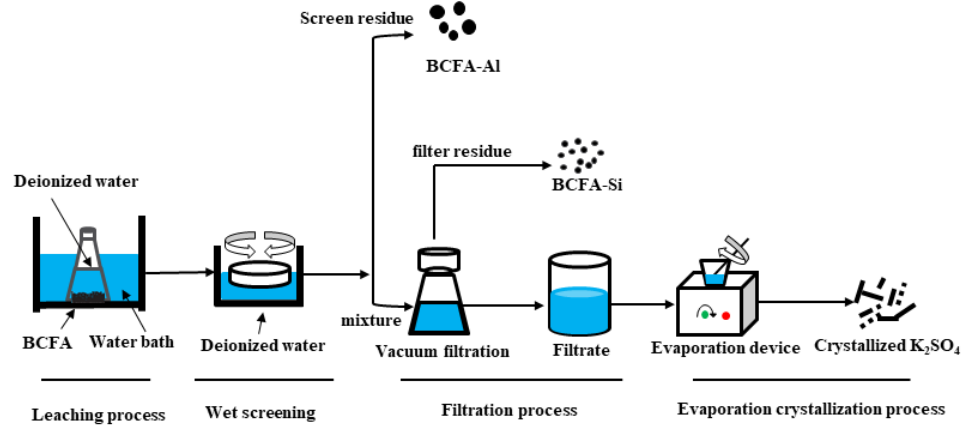
Figure 5. Schematic of the process for recovering K 2 SO 4 and separating Al 2 O 3 and SiO 2 from BCFA.